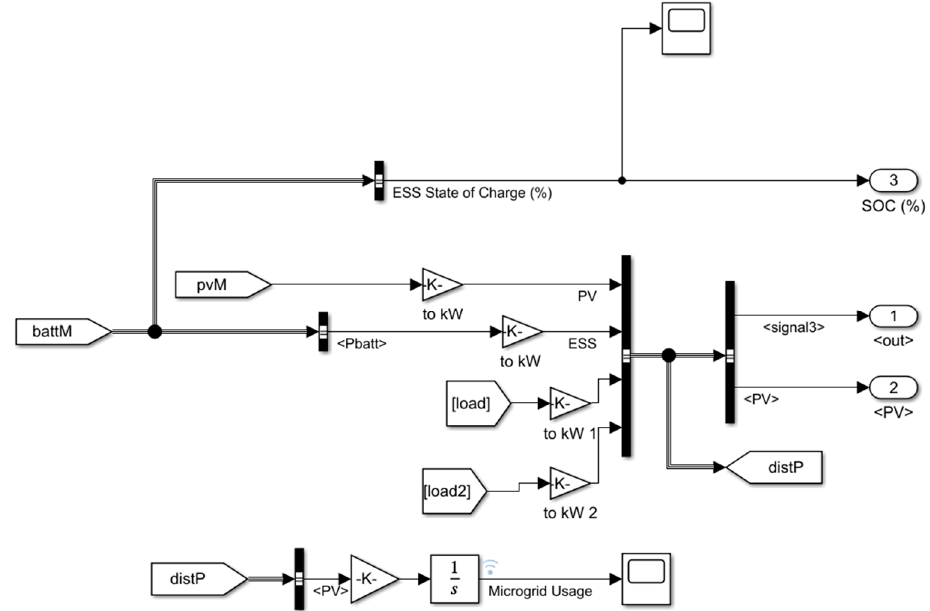
Figure 4. Block diagram of energy inlets and outlets to and from the microgrid.